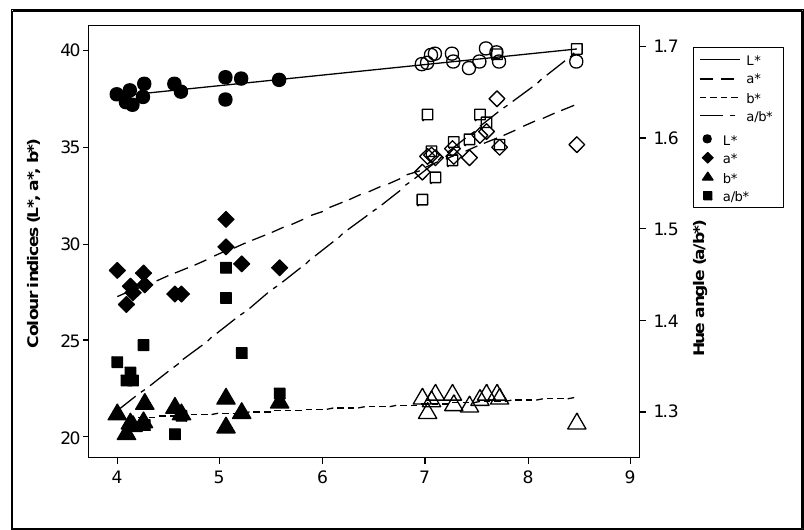
Figure 5 . Correlation between the colour indices L* (lightness of colour), a* (redness of hue), b* (yellowness of hue) and a/b* with the sum of all-trans lycopene, 9 cis lycopene and β-carotene during the experimental years. Solid symbols represent values in Year 1, while open symbols represent values in Year 2.